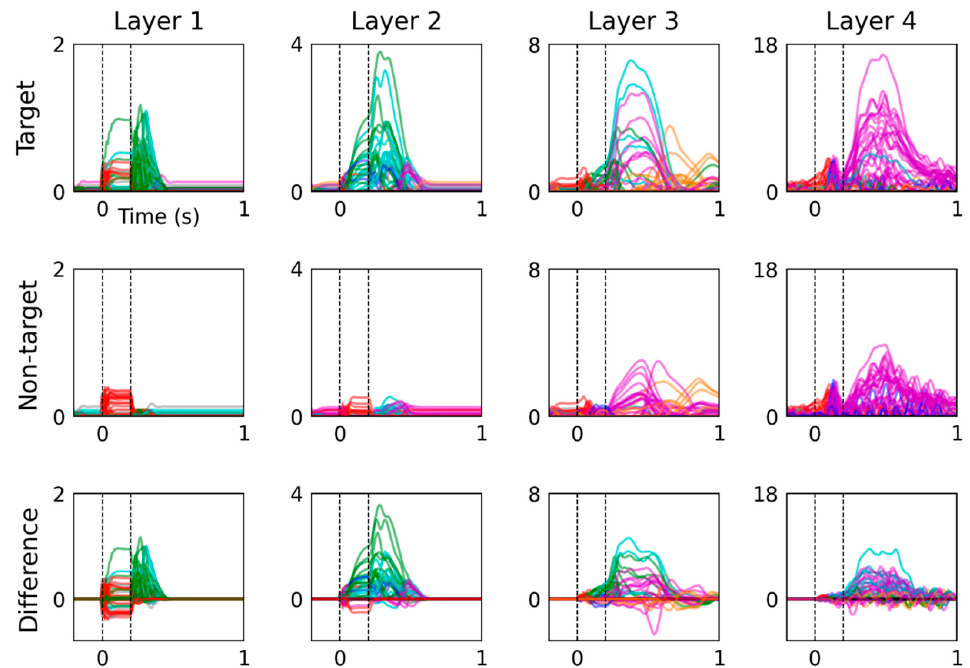
Figure 4. Time-domain analysis of hidden unit activations reveals distinct activity patterns in response to target and non-target input conditions. Hidden units were categorized by peak latency and their traces are colored as follows: no-peak (black), <0 s (grey), 0 to 0.1 s (red), 0.1 to 0.2 s (blue), 0.2 to 0.3 s (green), 0.3 to 0.4 s (cyan), 0.4 to 0.6 s (magenta) and >0.6 s (orange). The difference between hidden unit activations (bottom) was calculated by subtracting the responses to non-target input from those elicited by target input. Hidden unit class in the bottom row was determined by absolute peak latency.